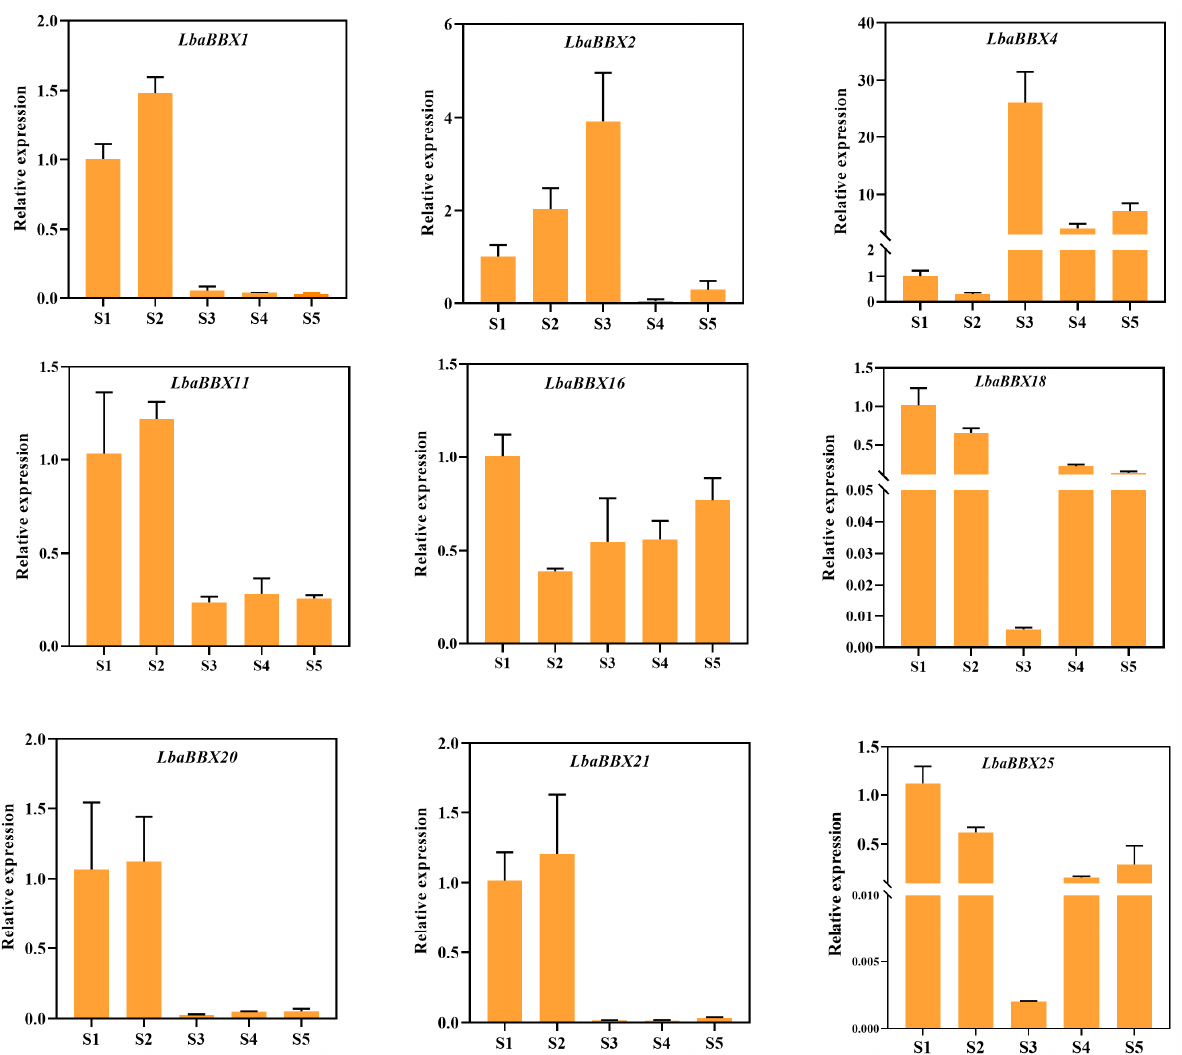
Figure 9. The relative expression levels of nine LbaBBX genes at different fruit developmental stages. Actin gene were used as reference gene to measure expression levels in each period. The x -axis indicates the five distinct fruit developmental stages (12 DAF, 19 DAF, 25 DAF, 30 DAF and 37 DAF). The y -axis indicates the relative expression. Data represent the means ± SDs ( n = 3).